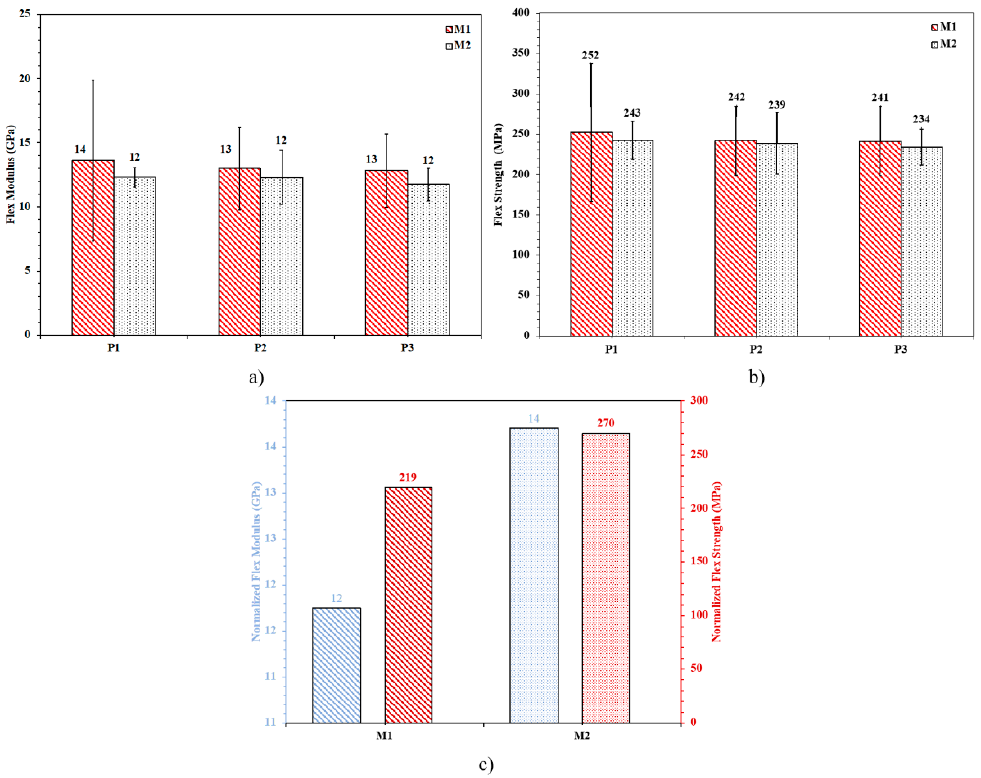
Figure 13. Flexural data for; ( a ) Flex modulus for Method 1 and Method 2 plates, ( b ) Flex strength for Method 1 and Method 2 plates, ( c ) Normalized average flex modulus and strength for Method 1 Set versus Method 2 set for a unified fiber weight fraction of 33%, the superiority of Method 2 is reflected by the positive slope of the trendline between the calculated values.